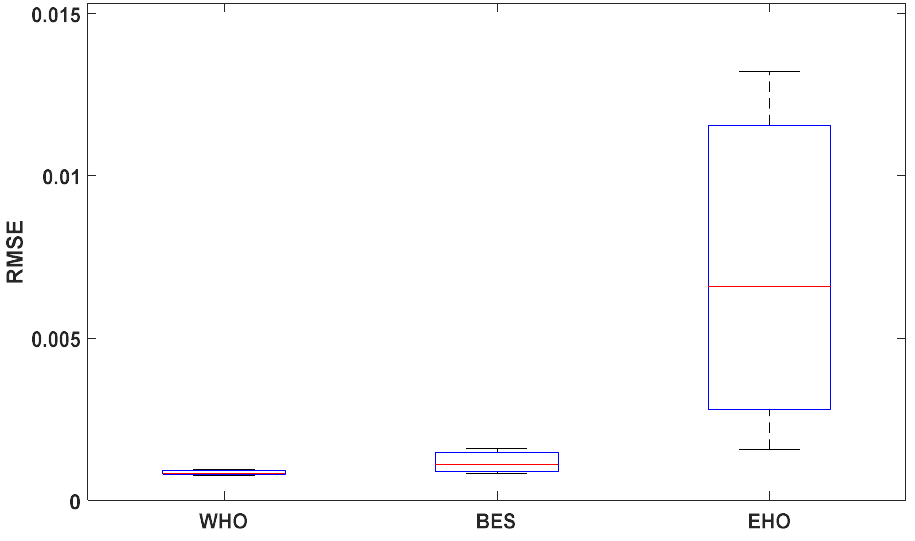
Figure 11. Boxplot of all algorithms for 30 independent runs applied to MDDM.